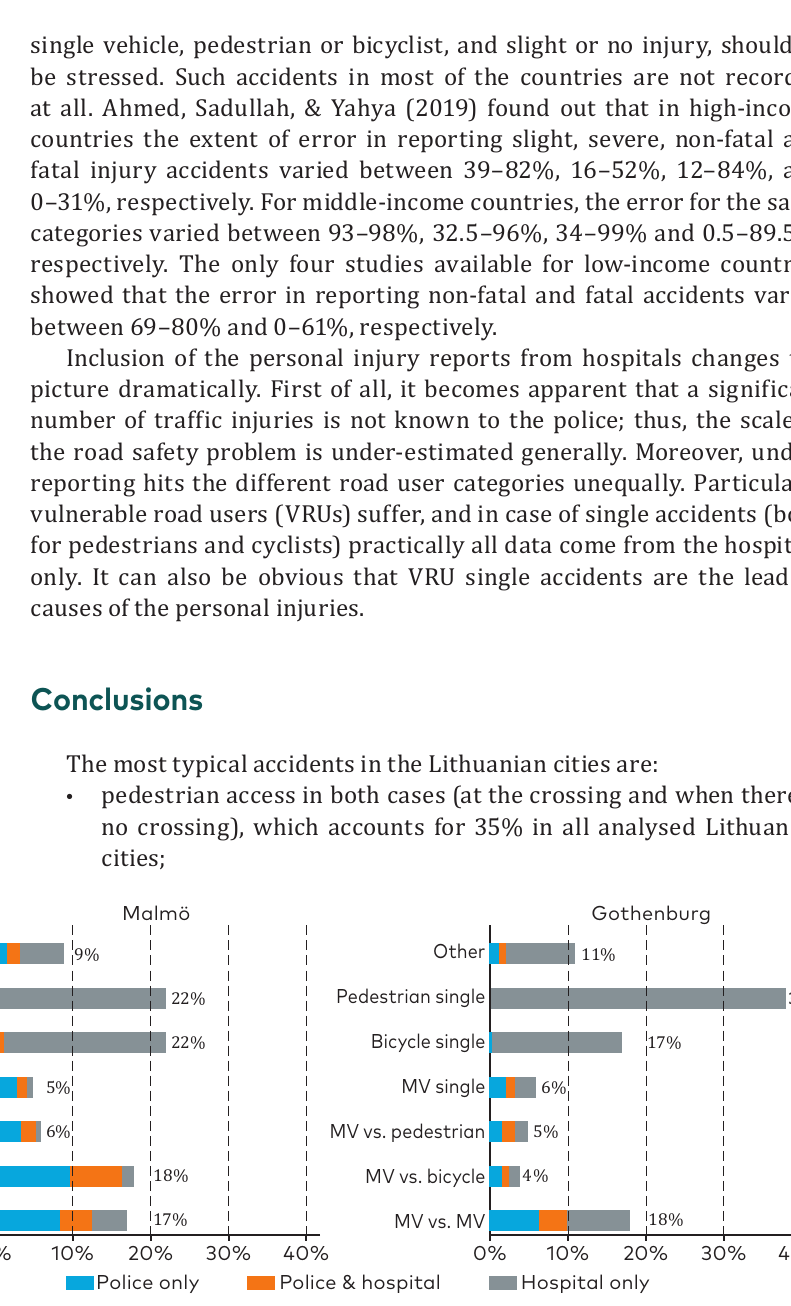
Figure 9. Personal injury accidents in Gothenburg and Malmö, 2017 (police and hospital data